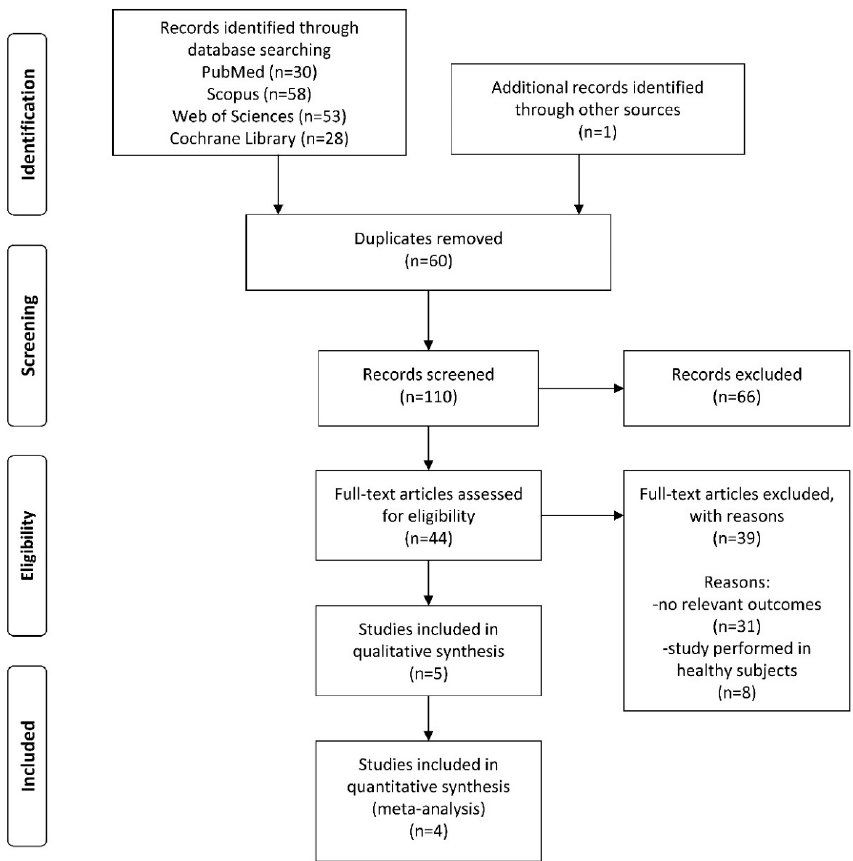
Figure 1. Process of the search .